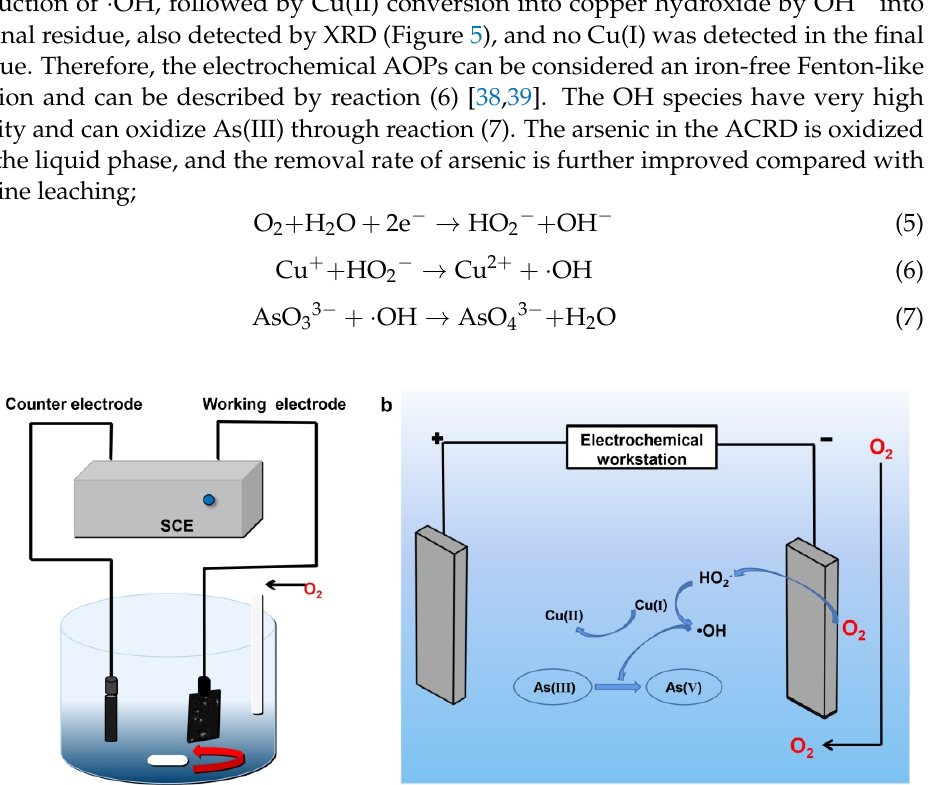
Figure 10. ( a ) Schematic diagram of the experimental setup and ( b ) Schematic diagram of the oxi- dation process of low arsenic by reactive oxygen